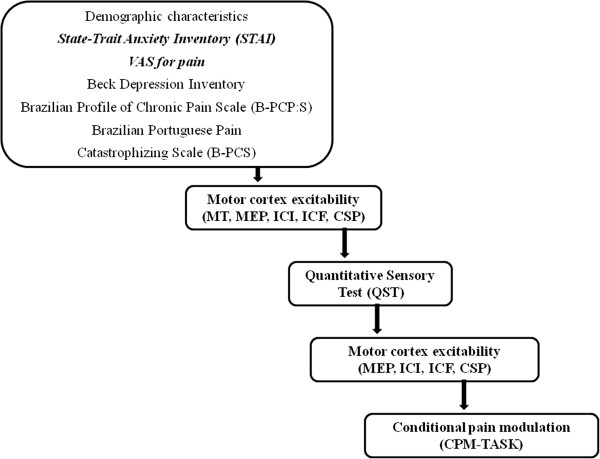
Flow of sequence of study steps.